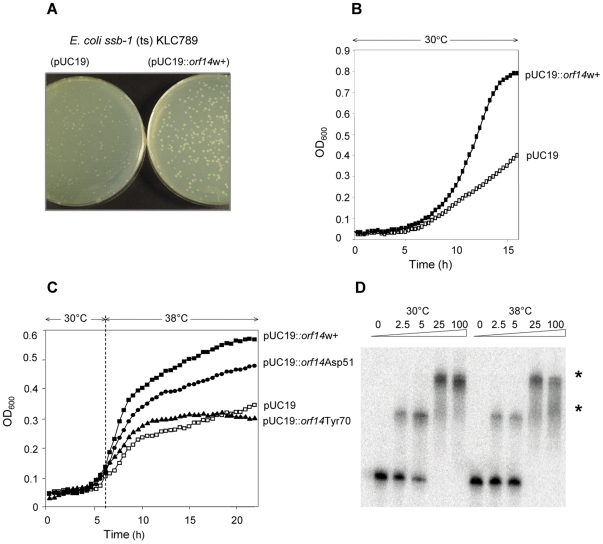
Rescue of the E. coli ssb-1 mutant strain KLC789 by the orf14bIL67.
A: Colony morphology of KLC789 (pUC19) and KLC789 (pUC19:orf14bIL67) strains on an LB agar plates in the presence of 0.25 mM of IPTG after 18 hours of incubation at 30°C. B: KLC789 (pUC19) (□) and KLC789 (pUC19:orf14bIL67) (▪) strains were grown in LB broth at 30°C in the presence of 0.25 mM of IPTG. C: KLC789 (pUC19) (□), KLC789 (pUC19:orf14bIL67) (▪), KLC789 (pUC19:orf14bIL67/D51A) (•) and KLC789 (pUC19:orf14bIL67/Y70A) (▴) strains were grown for 6 h at 30°C and then shifted to 38°C in a Bioscreen C apparatus (LabSystems), under continuous monitoring of OD600. The curves are generated from the means of four to six independent experiments; standard deviations were ≤10% (not shown). D: Binding of purified Orf14bIL67 to ssDNA at 30°C and 38°C. A series of concentrations (marked at the top) of the protein were incubated with 0.5 nM of an 80-mer oligonucleotide at two different temperatures (30°C or 38°C) prior to loading on the gel. Asterisks (*) mark the nucleoprotein complexes. The arrow indicates the position of free ssDNA.